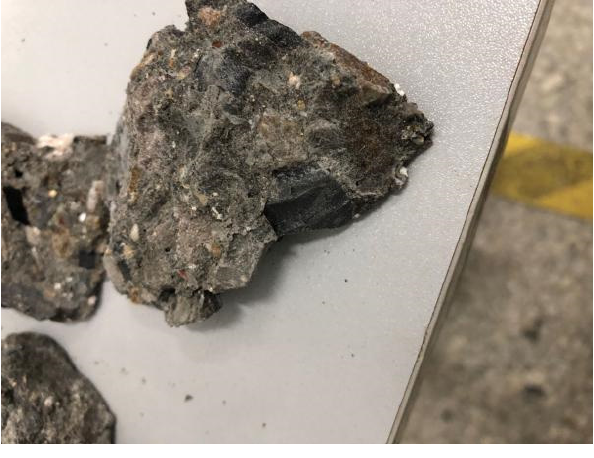
Figure 5. Damaged concrete fragments.